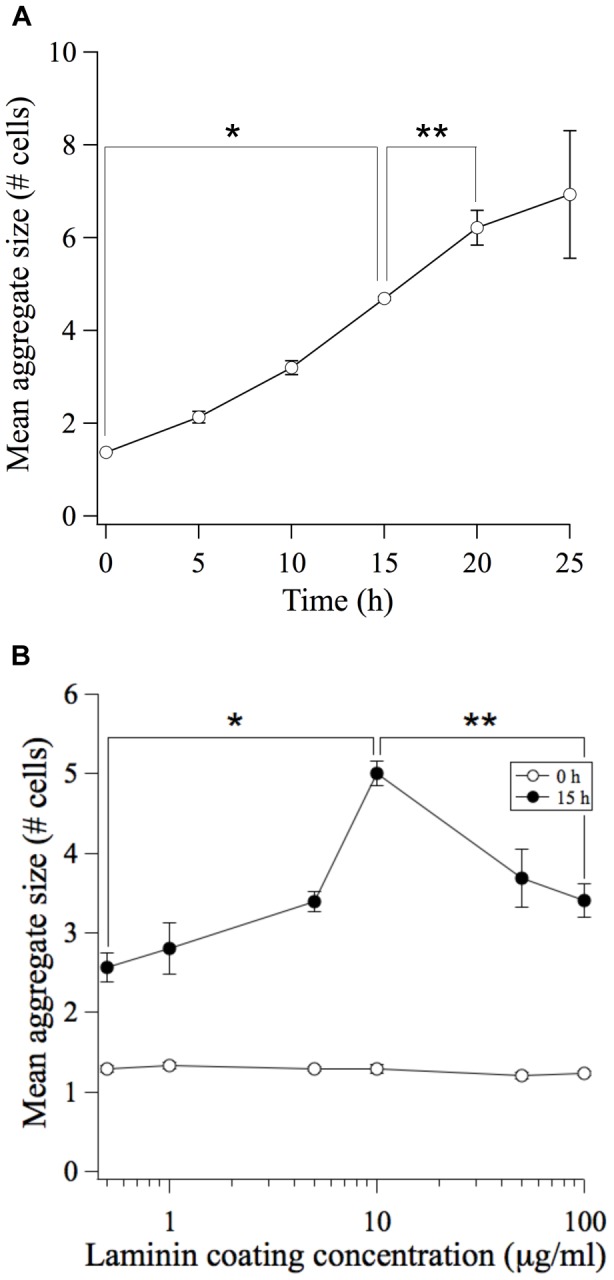
Biphasic dependence of aggregate size on substratum adhesivity: evidence for motility-limited aggregation dynamics.(A) The mean aggregate size (# of cells per aggregate) was quantified at initial time (0 h) and at multiple timepoints after the attachment of MDCK cells to the Ln-coated (10 µg/mL) substratum. Error bars, s.e.m. (n = 2 trials; N>350 aggregates per trial). *P<0.05 between 0 h and 15 h conditions. **P<0.06 between 15 h and 20 h conditions. (B) The mean aggregate size (# cells per aggregate) was quantified at initial time (0 h; open circles) and 15 h (closed circles) after the attachment of MDCK cells to Ln-coated substrata. Error bars, s.e.m. (n = 3–4 trials; N>350 aggregates per trial). *P<0.0005 between 0.5 µg/mL Ln and 10 µg/mL Ln conditions. **P<0.005 between 100 µg/mL Ln and 10 µg/mL Ln conditions.